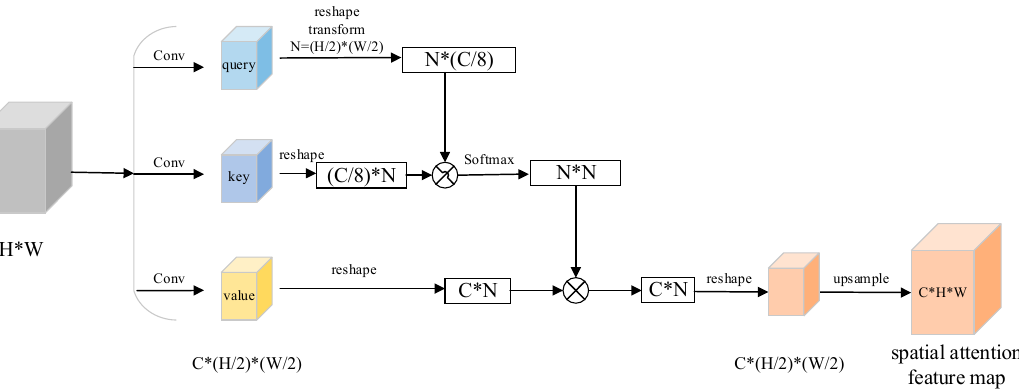
Figure 6. The computation process of DSA module used in conv3 feature map. The “C/8” is same with Figure 3b. Compared with Figure 3b, the convolution used to generate query, key and value feature maps is different, and it is used to reduce their spatial dimensions to reduce the computation of DSA. However, the output dimension of DSA will decrease, so we use nearest-neighbor interpolation to recover the output dimension.